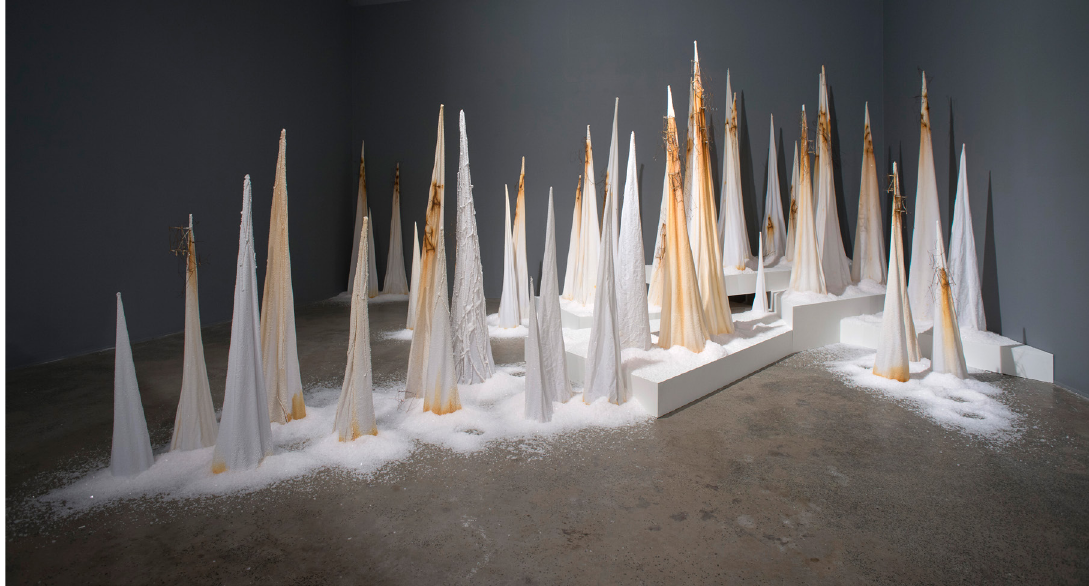
Figure 1 : Tracey Clement, Post-Premonitionism 2 , 2014-17, salt, rusty steel, cotton, dimensions variable, max height 180